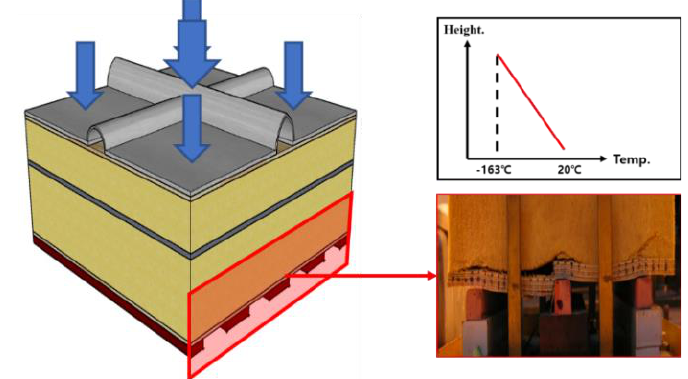
Figure 3. Stress concentration at the bottom of an insulation panel and the corresponding temperature gradient .